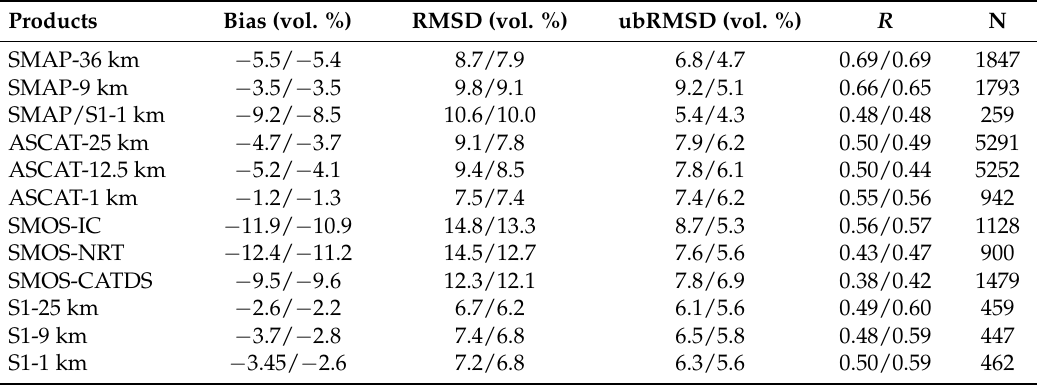
Table 1. Statistics of the comparison between SSM products and in situ SSM measurements. The format of results is “a/b”, where “a” corresponds to statistics obtained using all measurements together of all stations, and “b” corresponds to station average statistics. For all products, p -value of the comparison was lower than 0.01 which indicates that the correlation is